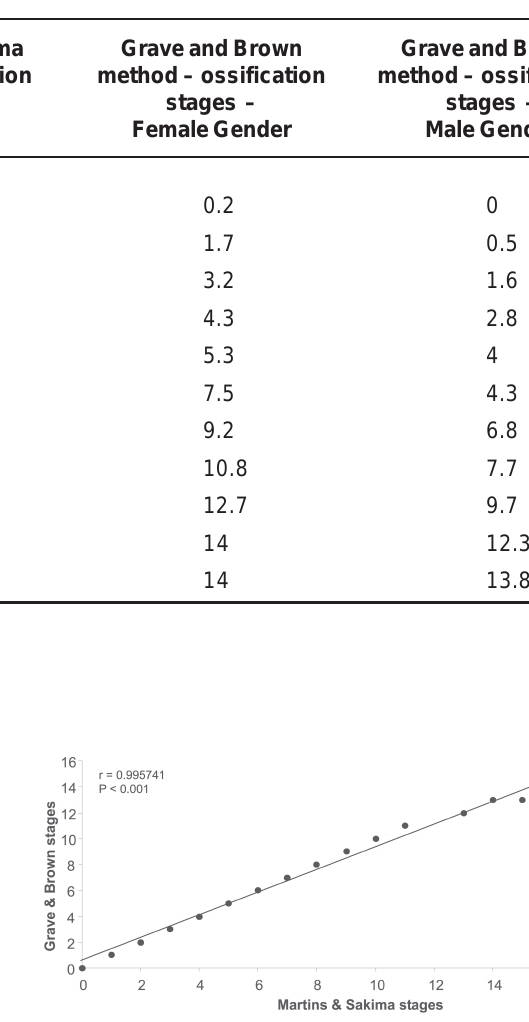
FIGURE 1- Graphic representation of the mean results of pubertal growth spurt prediction by the Martins and Sakima 14 and the Grave and Brown 6 method, applied to children with cleft lip and palate aged 7 and 17 years old